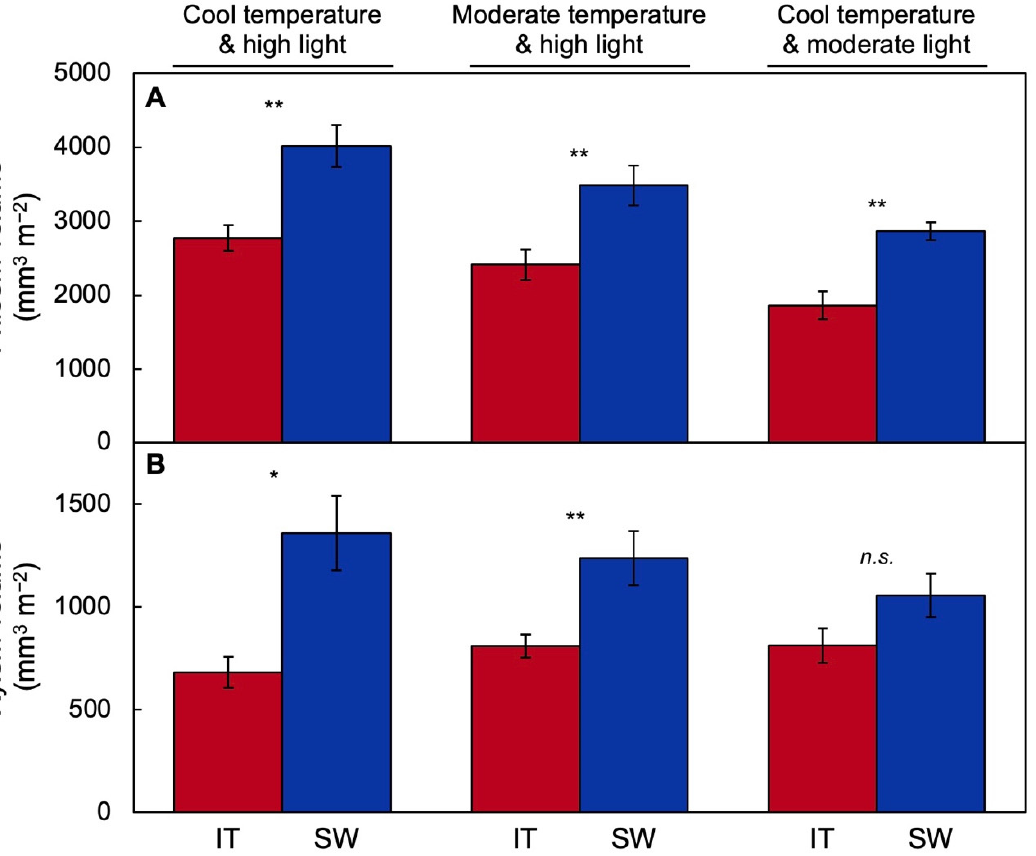
Figure 4. Minor-vein ( A ) phloem and ( B ) xylem volumes on a leaf area basis for IT (red columns) and SW (blue columns) grown under a cool temperature and high light (data from [24]), moderate temperature and high light (data from [59]), and cool temperature and moderate light (recalculated data from [24]). Mean values ± standard deviations ( n = 3 or 4); statistically significant differences between ecotypes based on Student’s t -tests are indicated with asterisks (* = p < 0.05; ** = p < 0.01); n.s. = not significantly different.